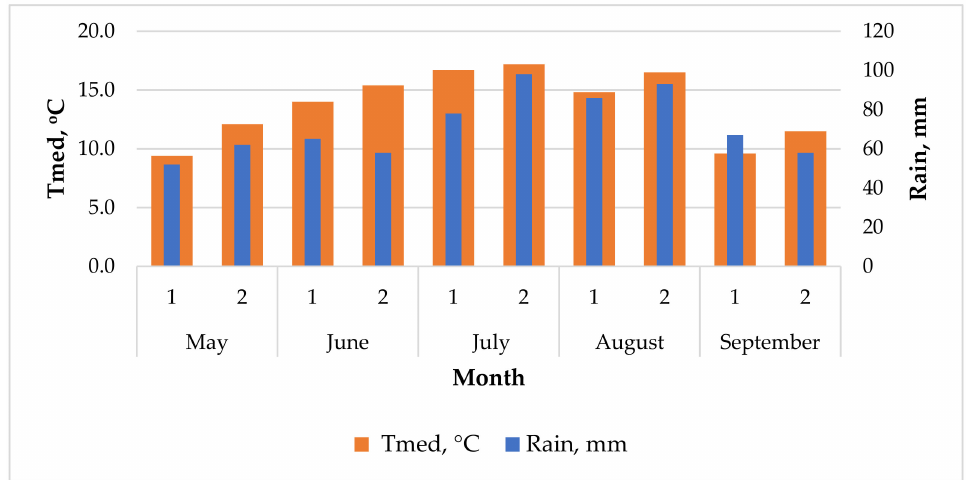
Figure 2. Average monthly air temperature and precipitation (1—average long-term data; 2—data of the period